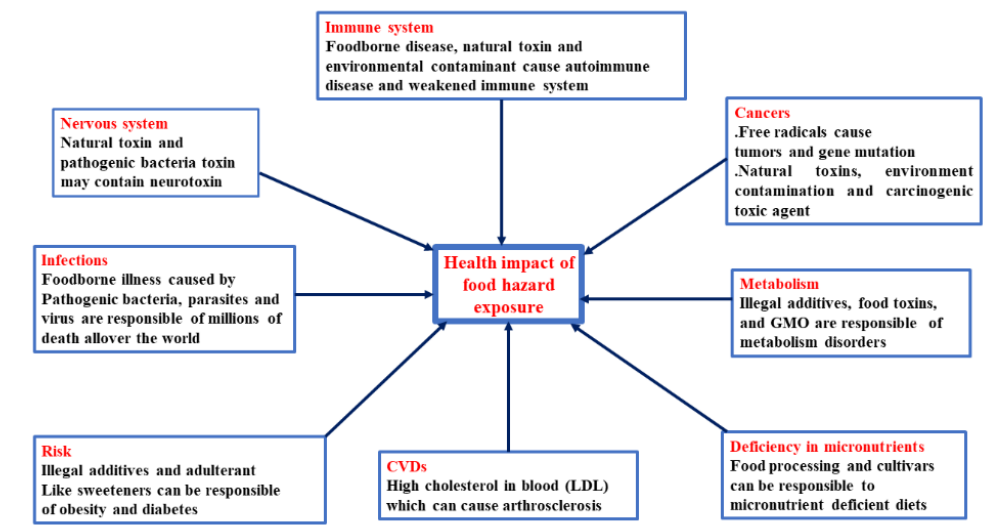
Figure 2. Health effects of food hazards and food contaminant exposure.